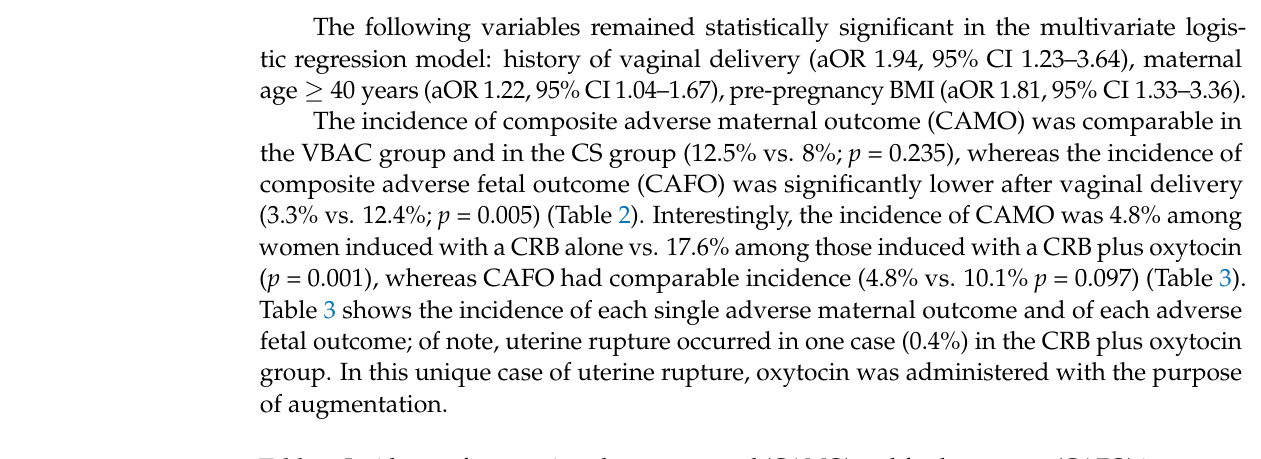
Table 3. Incidence of composite adverse maternal (CAMO) and fetal outcomes (CAFO) in